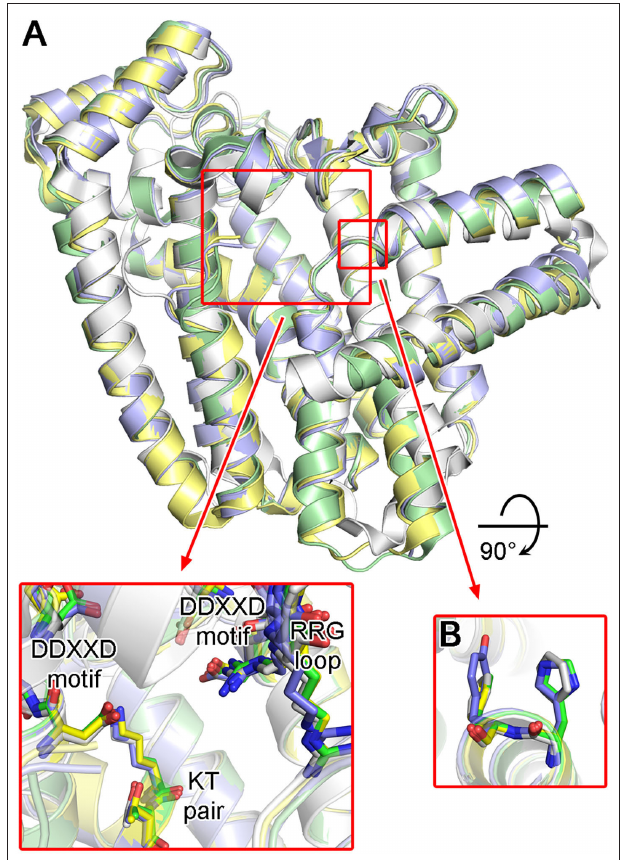
FIGURE 11 | Structures of trypanosomatid FPPS. (A) Superimposed structures of T. cruzi (green; PDB ID: 4DWG), T. brucei (light purple; PDB ID: 4RXD), L. major (yellow; PDB ID: 4JZX) and human FPPS (white; PDB ID: 4H5E). Conserved residues of the active site are displayed in the inset. (B) Aromatic residues of the allylic substrate site hydrophobic